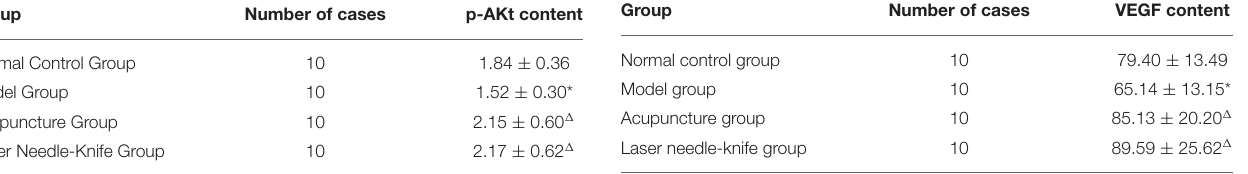
TABLE 4 | Comparison of p-AKt content in CSA Rabbits ( ¯ x ± S) (ng/mg). Group